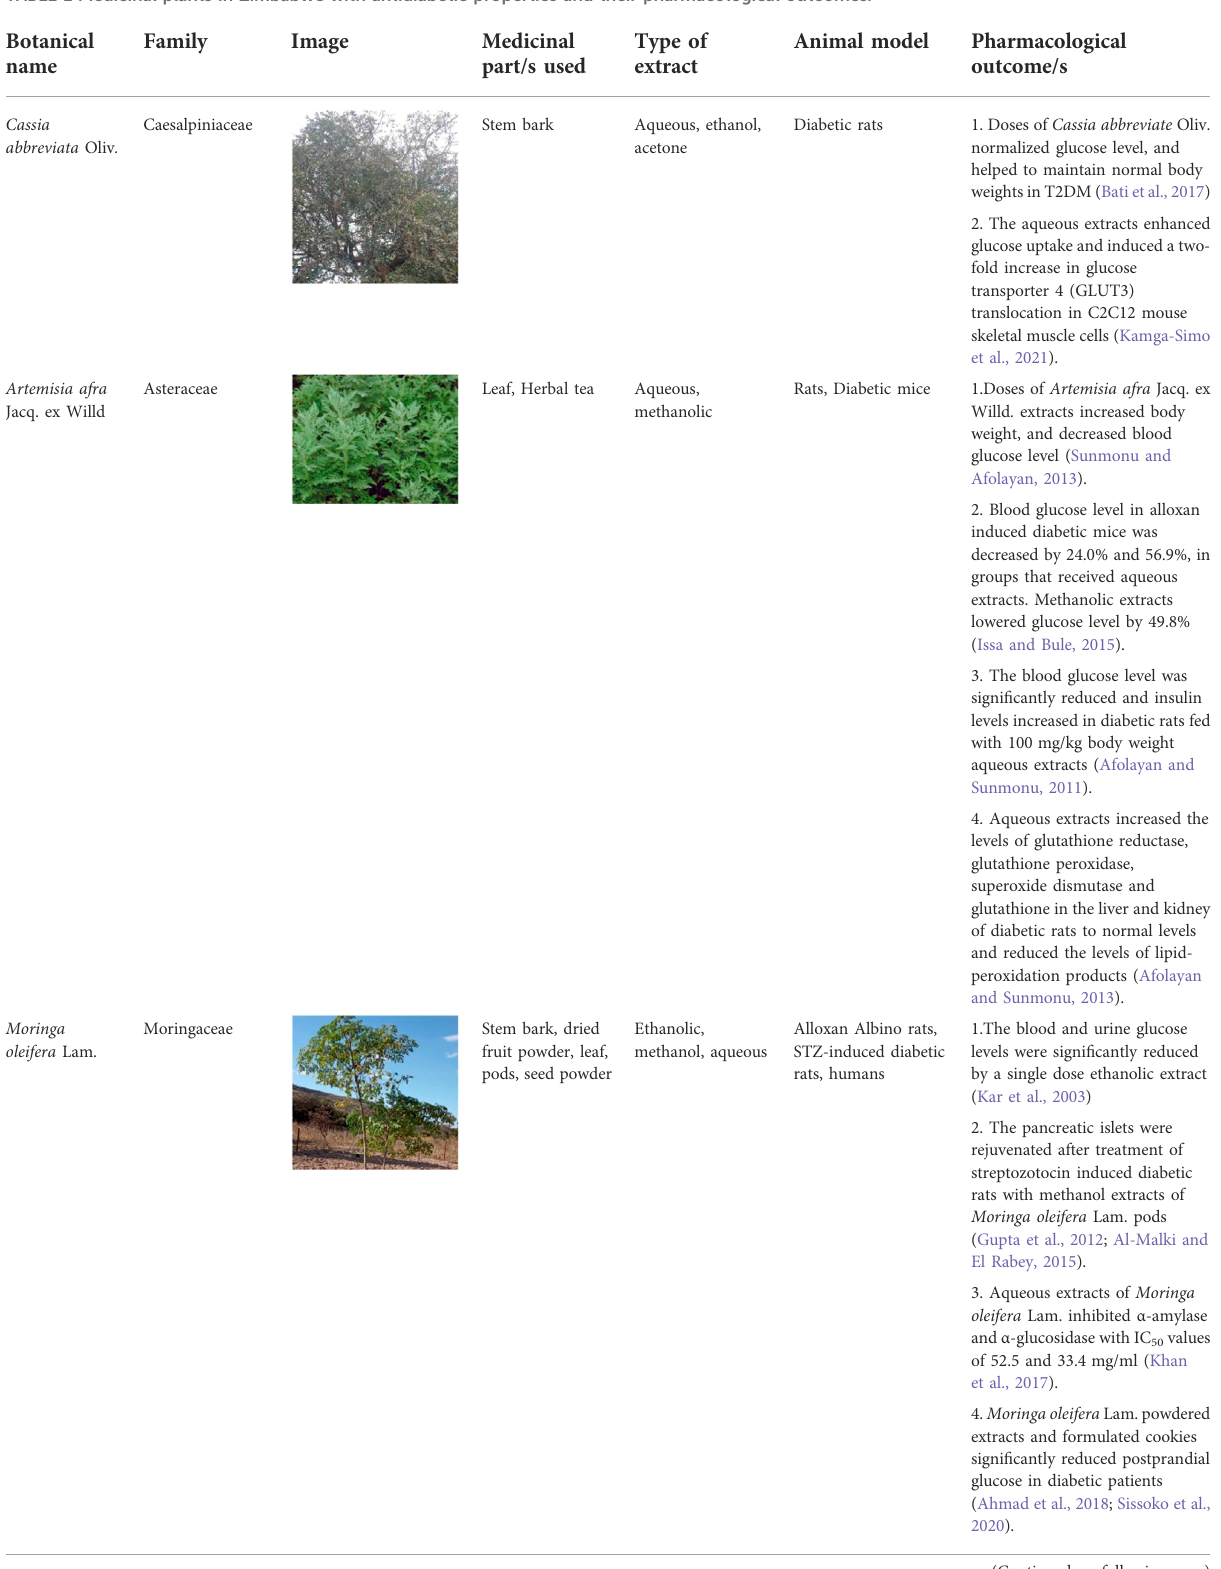
TABLE 1 Medicinal plants in Zimbabwe with antidiabetic properties and their pharmacological